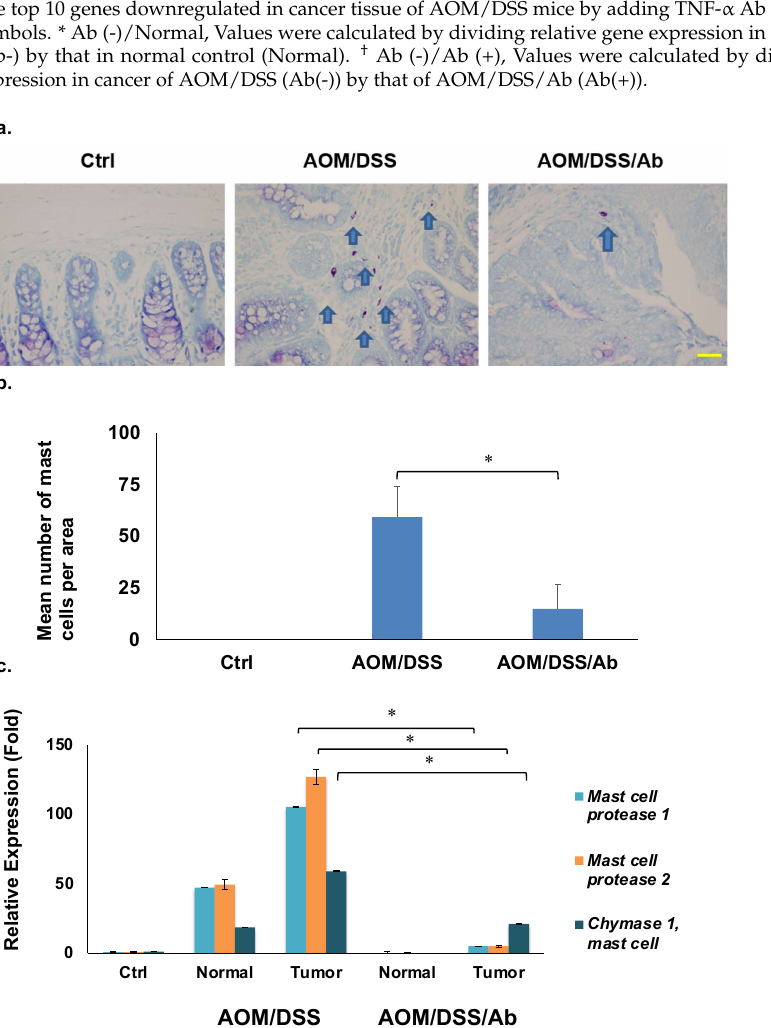
Figure 5. Results of staining and quantifying mast cells and RT-qPCR. ( a ) Mast cells stained with HCL-Toluidine blue (magnification: ×400). Scale bar represents 50 µm. ( b ) Comparison of mast cell numbers. ( c ) Results of RT-qPCR of mast cell protease 1 , mast cell protease 2 , and chymase 1 , * p < 0.01. Ab, Infliximab; AOM, azoxymethane; AOM/DSS, mice administered with AOM and DSS; AOM/DSS/Ab, mice administered with AOM, DSS, and infliximab; Ctrl, control; DSS, dextran so- dium sulfate; normal, normal tissue; tumor, cancer tissue.